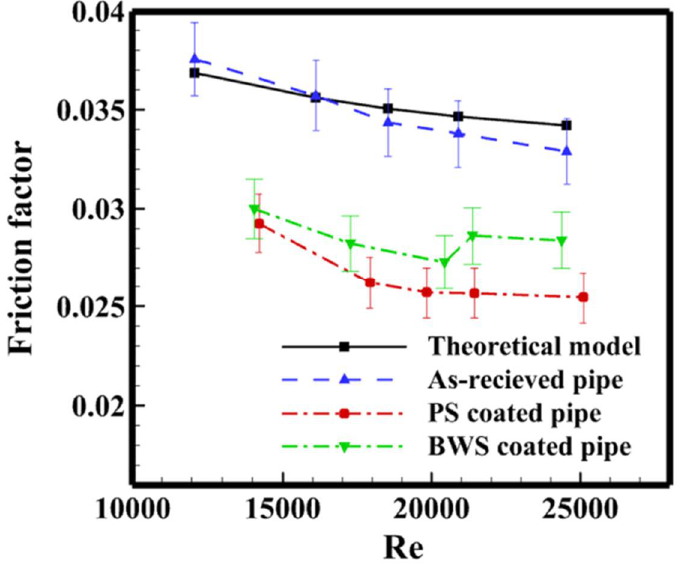
Figure 18. The friction factor at different Reynolds numbers. Reprinted with permission from Ref [95]. Copyright 2020 Elsevier.